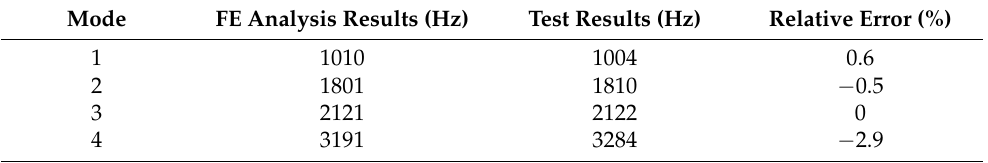
Table 3. Comparison of the natural frequencies between the FE analysis and modal